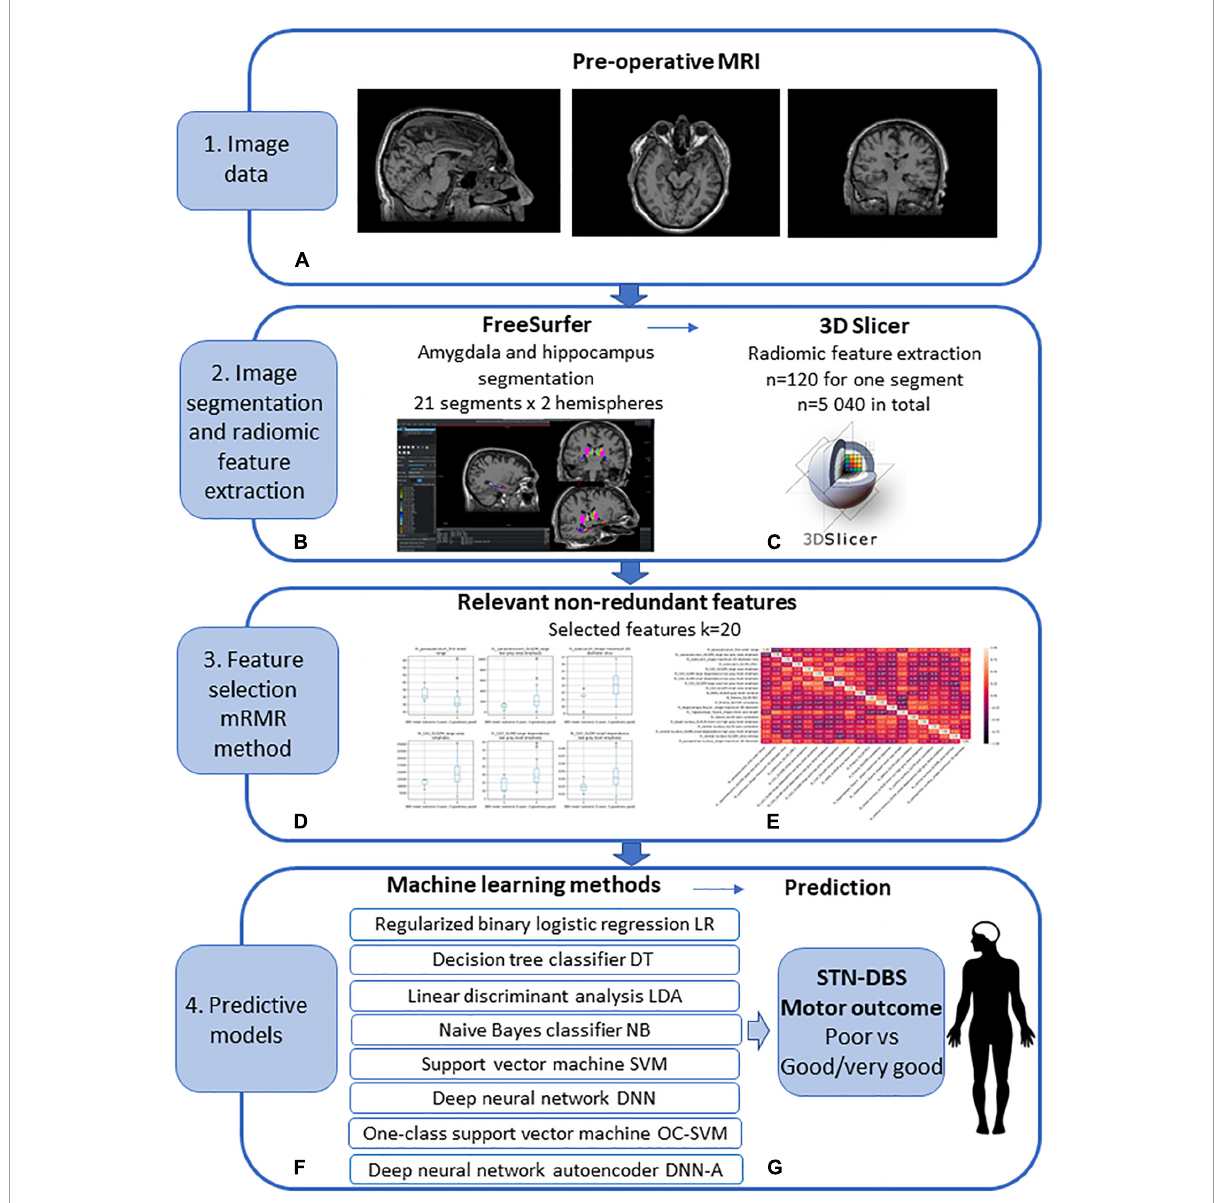
FIGURE1 Workflow diagram of the pre-operative prediction of subthalamic nucleus (STN) deep brain stimulation (DBS) for Parkinson’s disease (PD) patients. (1) (A) Image data: pre-operative MRI image acquisition using the 1.5 T Siemens Avanto scanner. (2) Image segmentation and radiomic feature extraction: (B) amygdala and hippocampus segmentation using FreeSurfer; obtained 21 segments for 2 hemispheres; (C) radiomic feature extraction using 3D Slicer; extracted features n = 120 for every segment, n = 5 040 in total. (3) Feature selection using Minimum Redundancy Maximum Relevance (mRMR) method: (D) selected relevant features (E) selected non-redundant features k = 20. (4) Predictive machine learning models: (F) regularized binary logistic regression (LR), decision tree classifier (DT), linear discriminant analysis (LDA), naive Bayes classifier (NB), kernel support vector machine (SVM), deep feed-forward neural network (DNN), one-class support vector machine (OC-SVM), feed-forward neural network-based autoencoder for anomaly detection (DNN-A); (G) prediction of the STN-DBS motor outcome: poor vs. good/very good